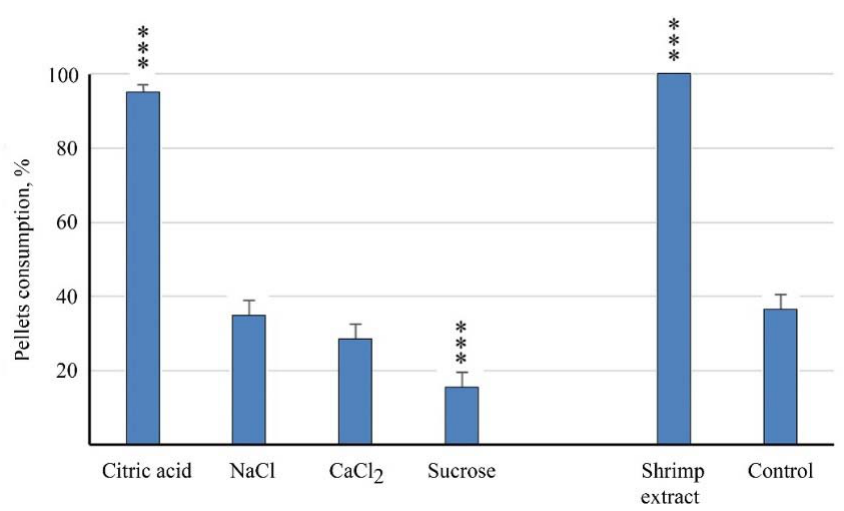
Figure 2. Palatability of agar gel (2%) pellets flavored with basic taste substances, 0.1 M, and shrimp Penaeus vannamei water extract, 300 g (wet weight)/L for barramundi Lates calcarifer juveniles. ***—differences from the control are significant at p < 0.001 ( χ 2 ‐ test). Whiskers are the s.e.m.